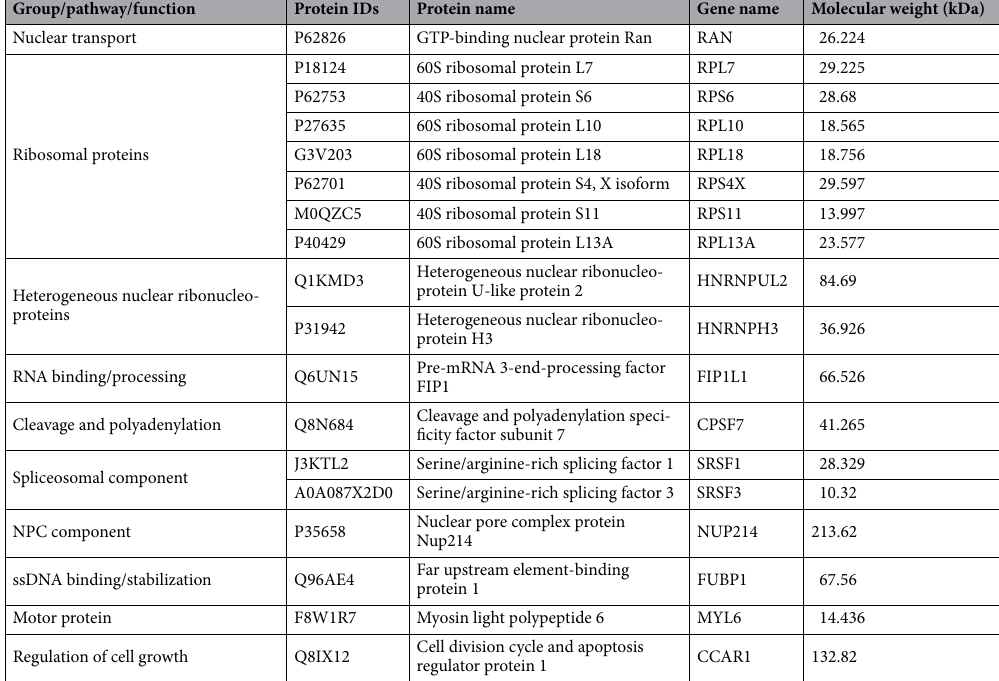
Table 2. List of 18 common protein hits identified by IP-MS in the Kpnβ1 co-IP experiments unique to human cervical and oesophageal cancer cells